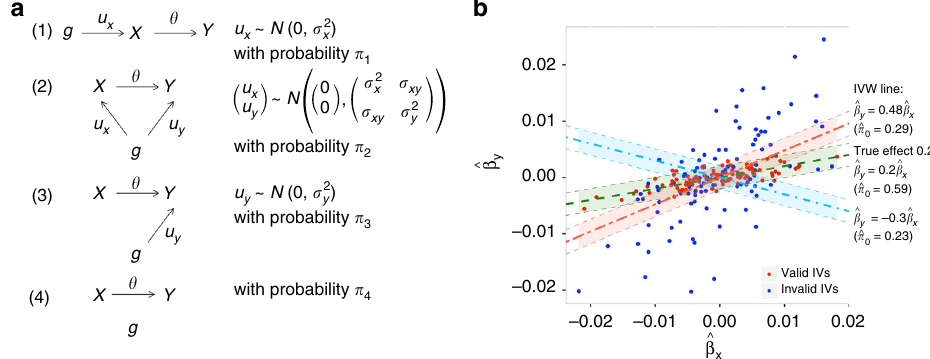
Fig. 1 Overview of MRMix approach. a Four components of the Mendelian randomization mixture (MRMix) model: (1) Direct effect on X and an indirect effect on Y only through X ; (2) direct effects on both X and Y ; (3) direct effect on Y but no relationship with X ; (4) related to neither X nor Y . Direct effects are denoted by u x and u y and the causal effect is denoted by θ . Parameters π 1 , π 2 , π 3 , π 4 are the mixing probabilities associated with components (1), (2), (3), and (4), respectively; within each component, we assume u x and u y to either be 0 or follow normal distributions and σ 2 covariance parameters. b Schematic of the MRMix estimation algorithm. The line corresponding to the true causal effect (0.2) maximizes the number of points “ close ” to the line. Here the regions that are covered by the 95% probability band under the null distribution (shaded area, expressed as q ffiffiffiffiffiffiffiffiffiffiffiffiffiffiffiffiffiffiffi (cid:1) (cid:1) (cid:1) (cid:1) ^ β θ ^ β θ 2 s 2 (cid:1) (cid:1) (cid:3) 1 : 96 ) are highlighted. We plot the line ^ β s 2 y (cid:1) x y þ x of valid IVs. Source data are provided as a Source Data fi